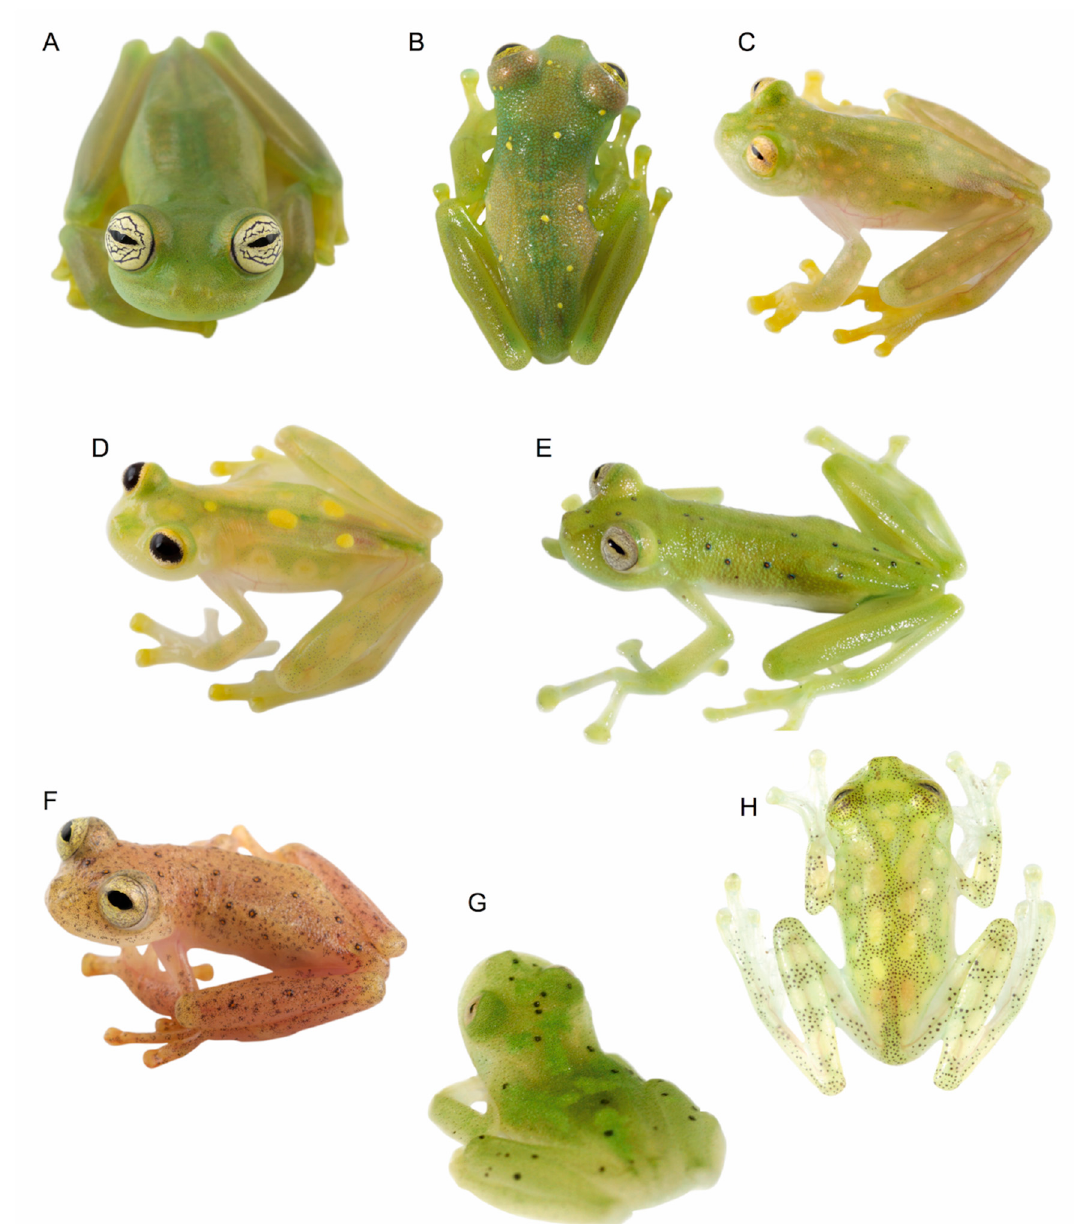
Figure 2. Dorsal color patterns in glassfrogs. ( A ) Uniform; Sachatamia ilex , QCAZ 47193. ( B ) With small and well-defined yellow spots; Nymphargus humboldti sp. nov., QCAZ 41084. ( C ) With small and diffuse yellow spots; Hyalinobatrachium fleischmanni , QCAZ 45386. ( D ) With large yellow spots; H . aureoguttatum , QCAZ 45365. ( E ) With small ocelli, N . cochranae , QCAZ 31113. ( F ) With ocelli and dark flecks; N . anomalus , QCAZ 47507. ( G ) With irregular light-green marks and small well-defined black spots, H . iaspidiense , QCAZ 38438. ( H ) With green reticulation; H . cf. valerioi , ZSFQ 0544 (photo by Jose Vieira). All photographs by Luis A. Coloma, except when noted.